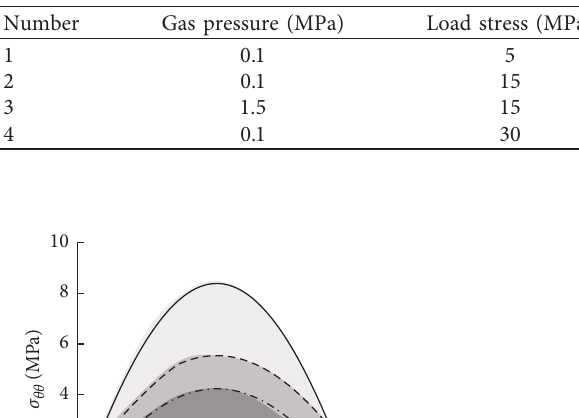
Table 1: Modeling scheme.